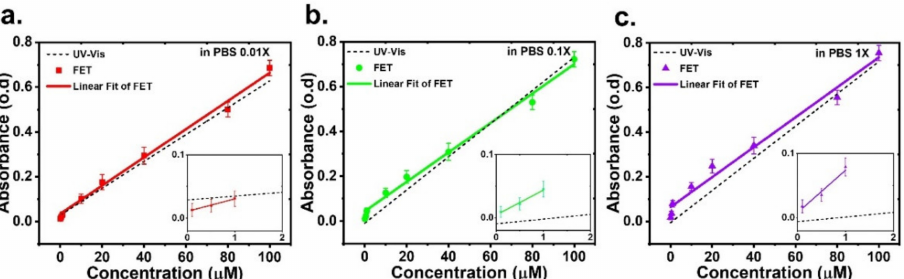
Figure 7. A comparison between the absorbance obtained with our opto-FET system (solid lines) and with a commercial UV–Vis spectrometer (dot-dashed lines) in PBS concentration of ( a ) 0.01X ( b ) 0.1X, and ( c ) 1X. The evaluation was performed at a wavelength of 450 nm and light intensity at 500 nWcm − 2 , V DS = 0.5 V, and V BG = 2.8